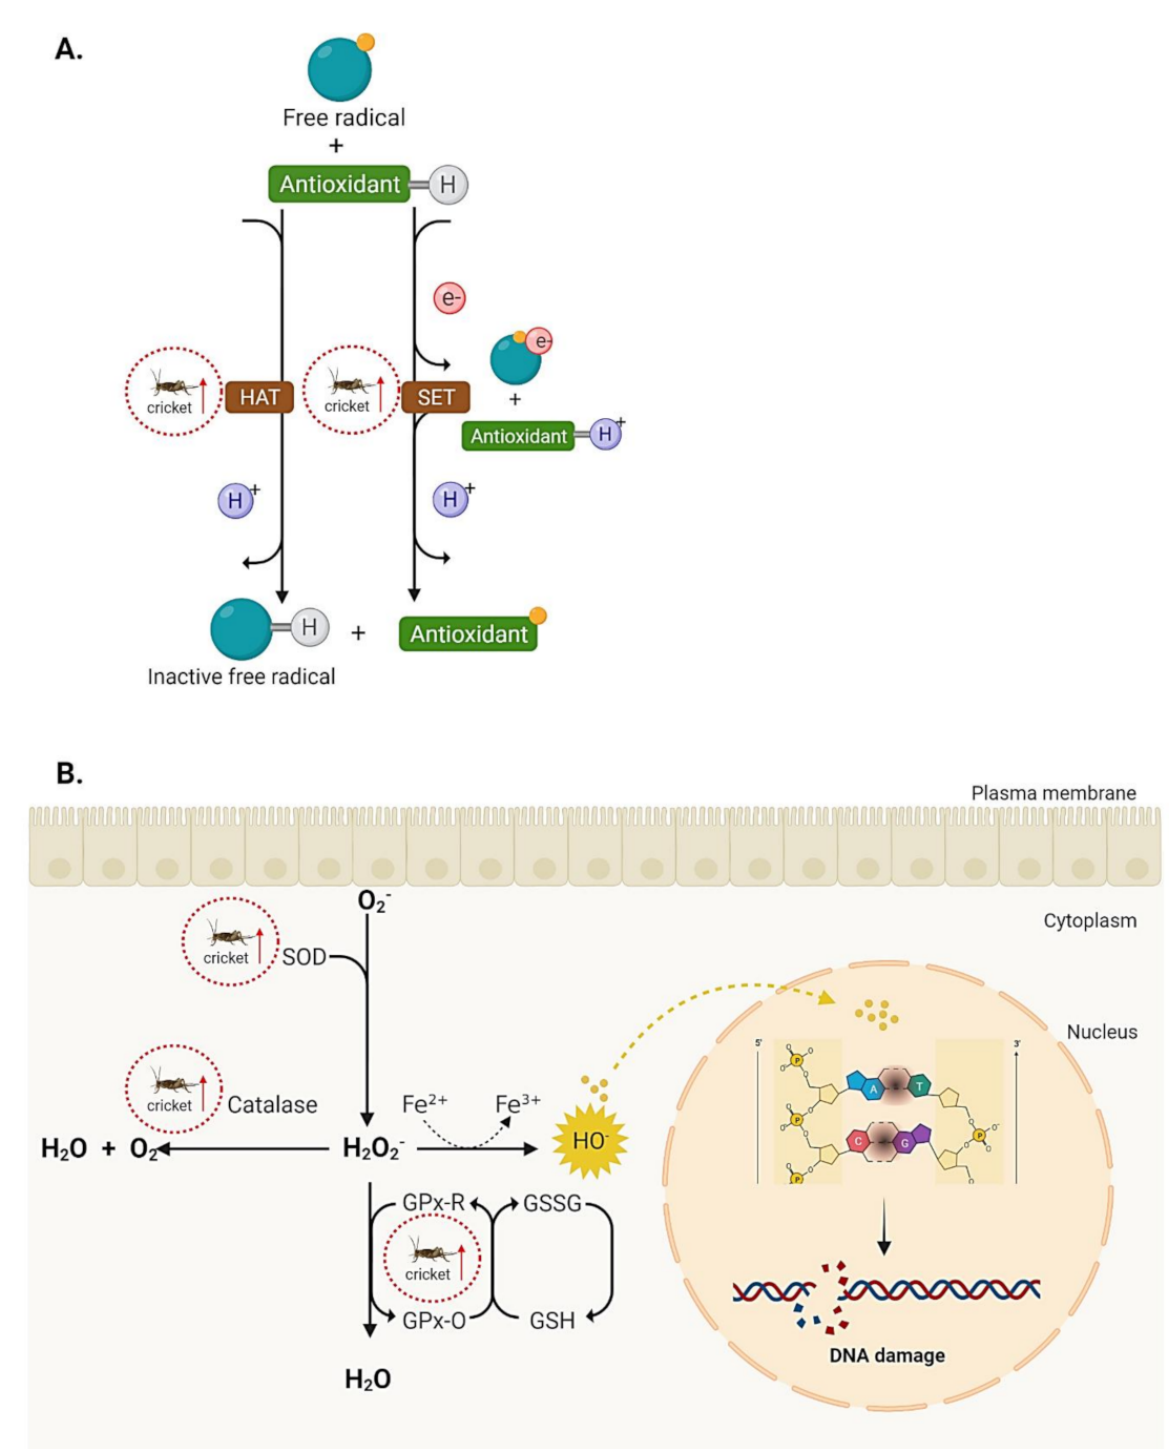
Figure 3. Antioxidant mechanisms showing how crickets exhibit antioxidant properties. ( A ) In vitro antioxidant mechanism through HAT and SET mechanisms. ( B ) Cellular antioxidant mechanisms through catalase, GPx and SOD. Improper regulation of free radicals may lead to DNA damages. GPx: glutathione peroxidase; GSH: glutathione; SOD: superoxide